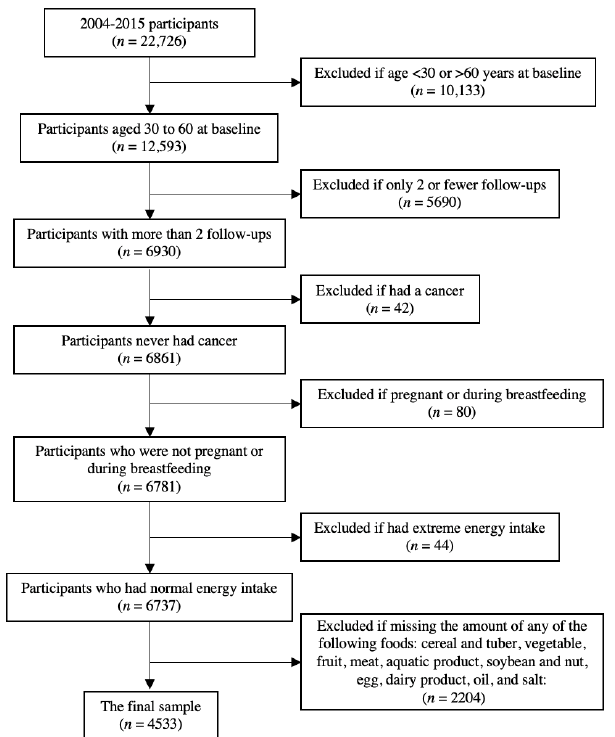
Figure A1. Flowchart of sample selection.